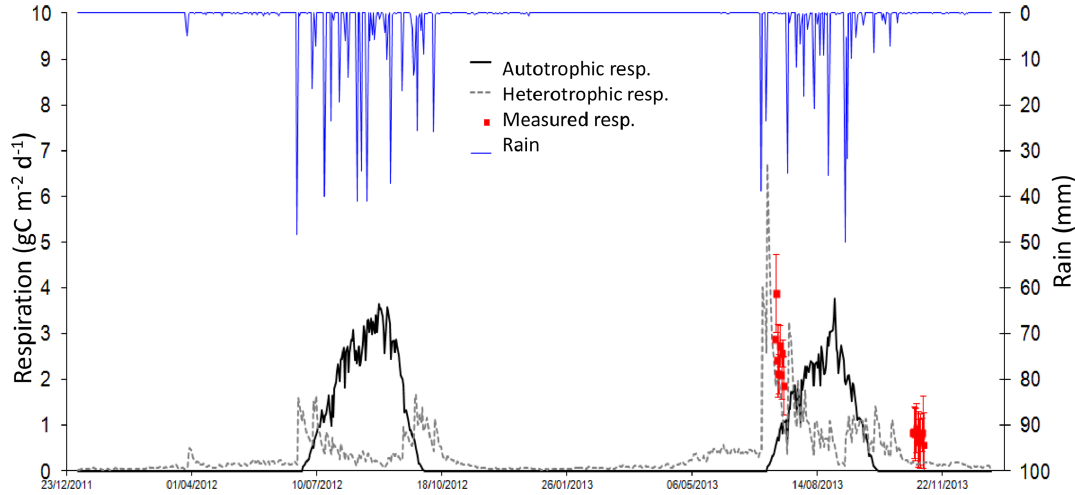
Figure 8. Daily autotrophic (roots + green vegetation, black line) and daily heterotrophic (microbes, grey dashed line) respiration (mgCm − 2 d − 1 ) and rain (blue line, mm). Averaged daily measurements of soil respiration as red squares, with standard